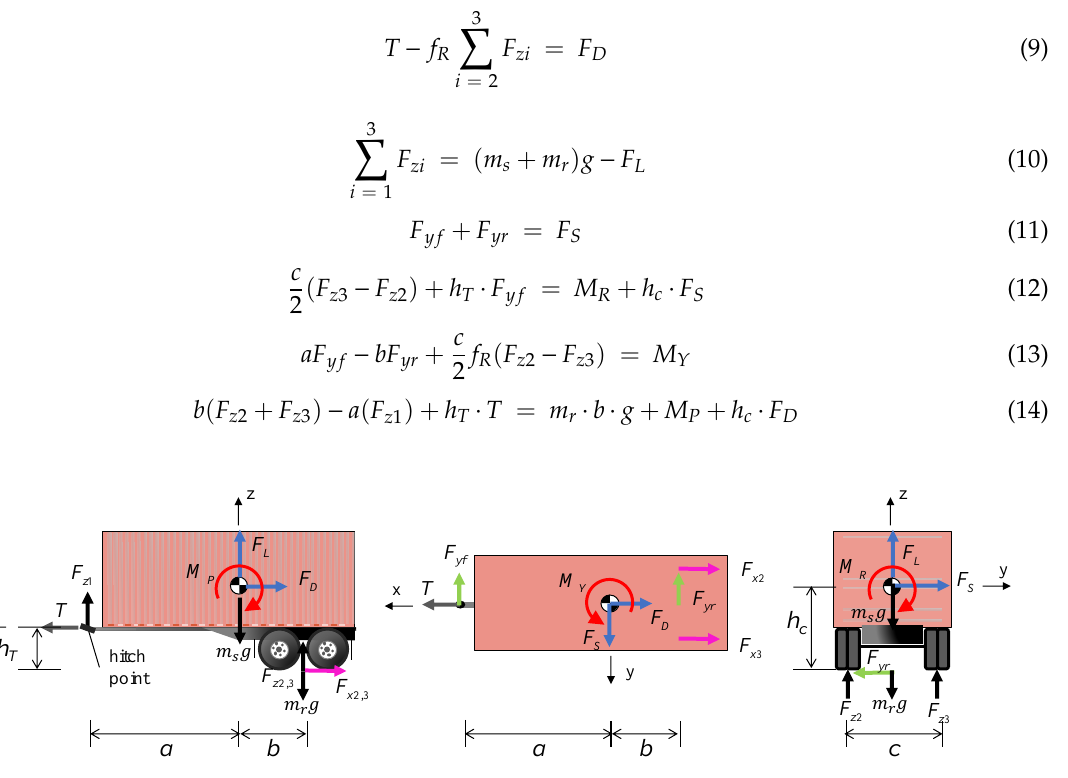
Figure 2. Applied actions and corresponding tire forces of trailers.